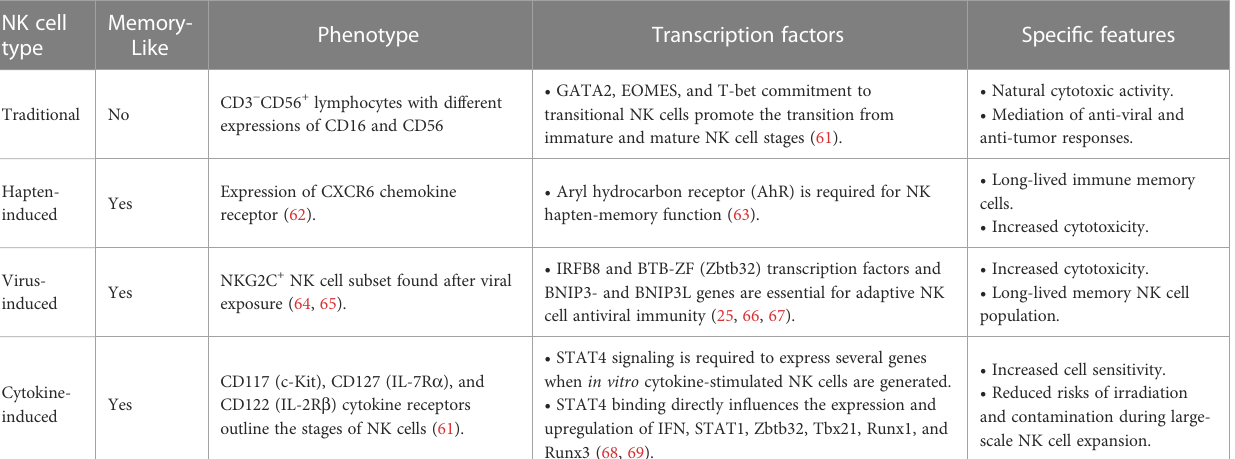
TABLE 3 Types of memory-like NK